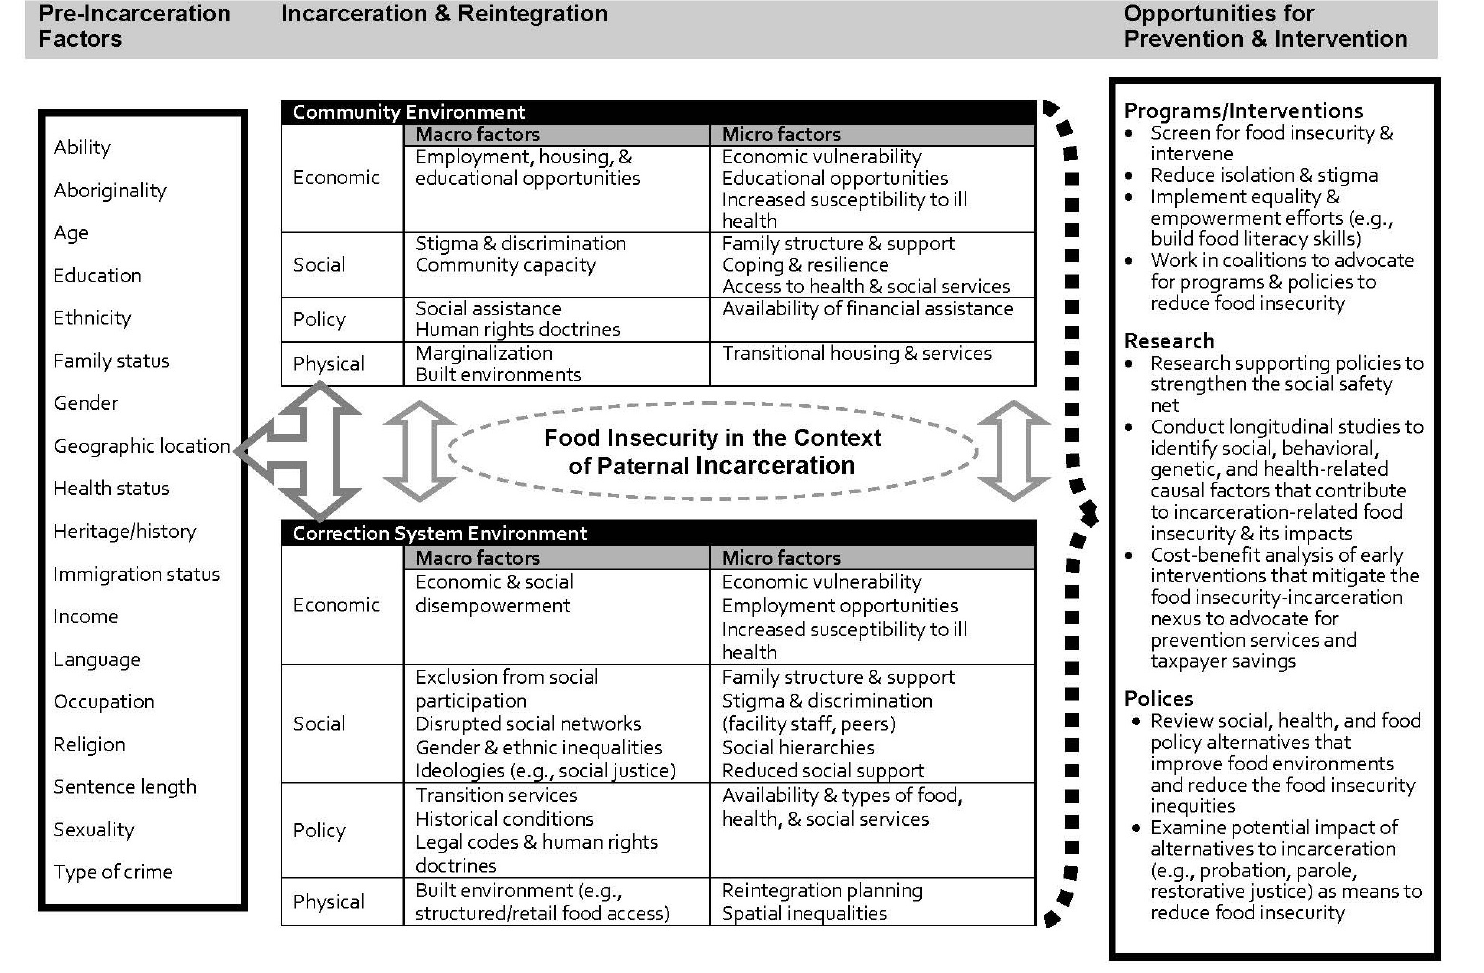
Figure 1. Factors influencing family food insecurity related to paternal incarceration.